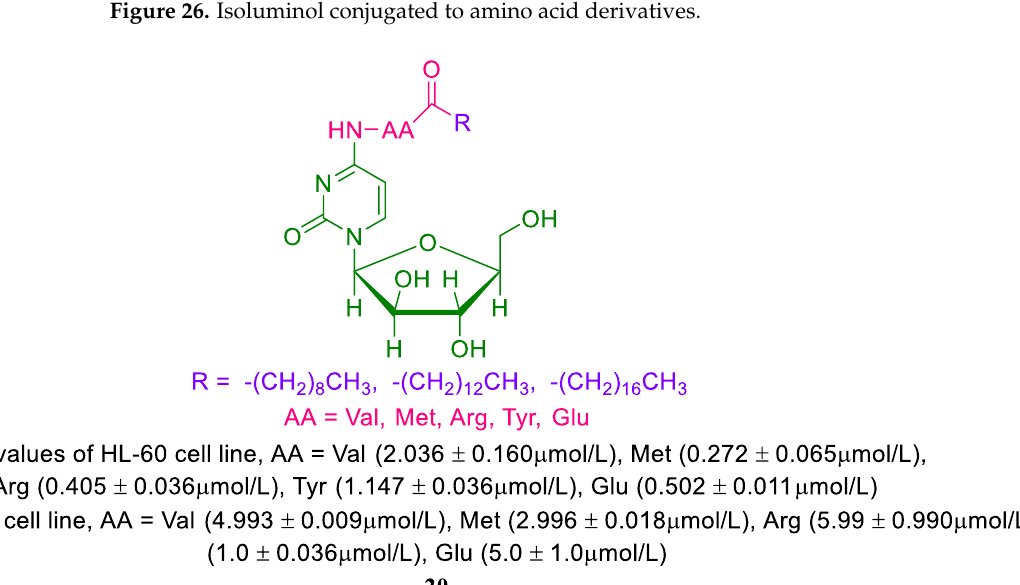
Figure 26. Isoluminol conjugated to amino acid derivatives.